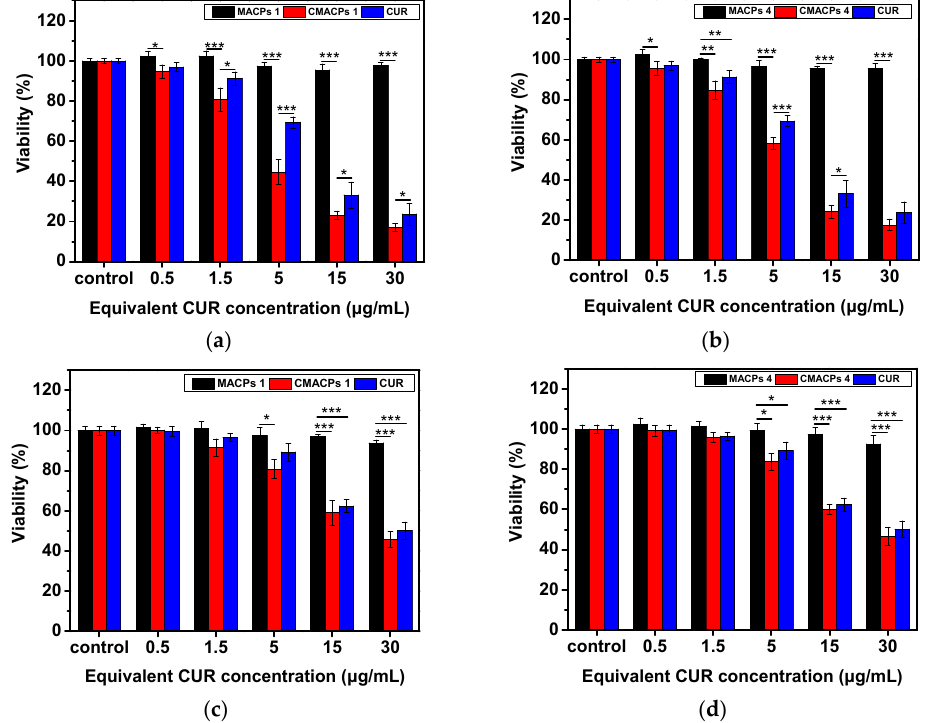
Figure 8. The in vitro MTT assay suggested CMACPs exhibited significantly higher cytotoxicity towards MDA-MB-231 breast cancer cells than to HDF cells. MDA-MB-231 cells ( a , b ) and HDF cells ( c , d ) were treated with free CUR, CMACPs 1, CMACPs 4 and blank MACPs 1, MACPs 4 for 48 h. CMACPs 1 and 4 (or MACPs 1 and 4) represent CMACPs (or MACPs) that possess 1 and 4 layers of polymers, respectively. The amounts of CUR in CUR loaded nanoparticles were equivalent to the amounts of free CUR (0.5–30 µ g/mL), respectively. The results are shown in mean ± SD, n ≥ 3. The statistical significance is expressed as *** p < 0.001, ** p < 0.01, * p